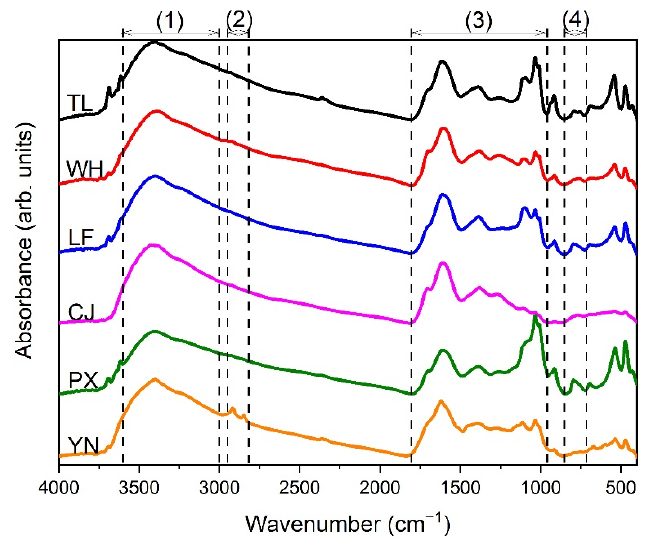
Figure 1. FTIR spectra of weathered coal from different geographical locations. Functional group regions: (1) hydroxyl groups; (2) aliphatic CHx; (3) oxygenated groups and aromatic carbon; (4) aromatic carbon. For peak assignments, see Table